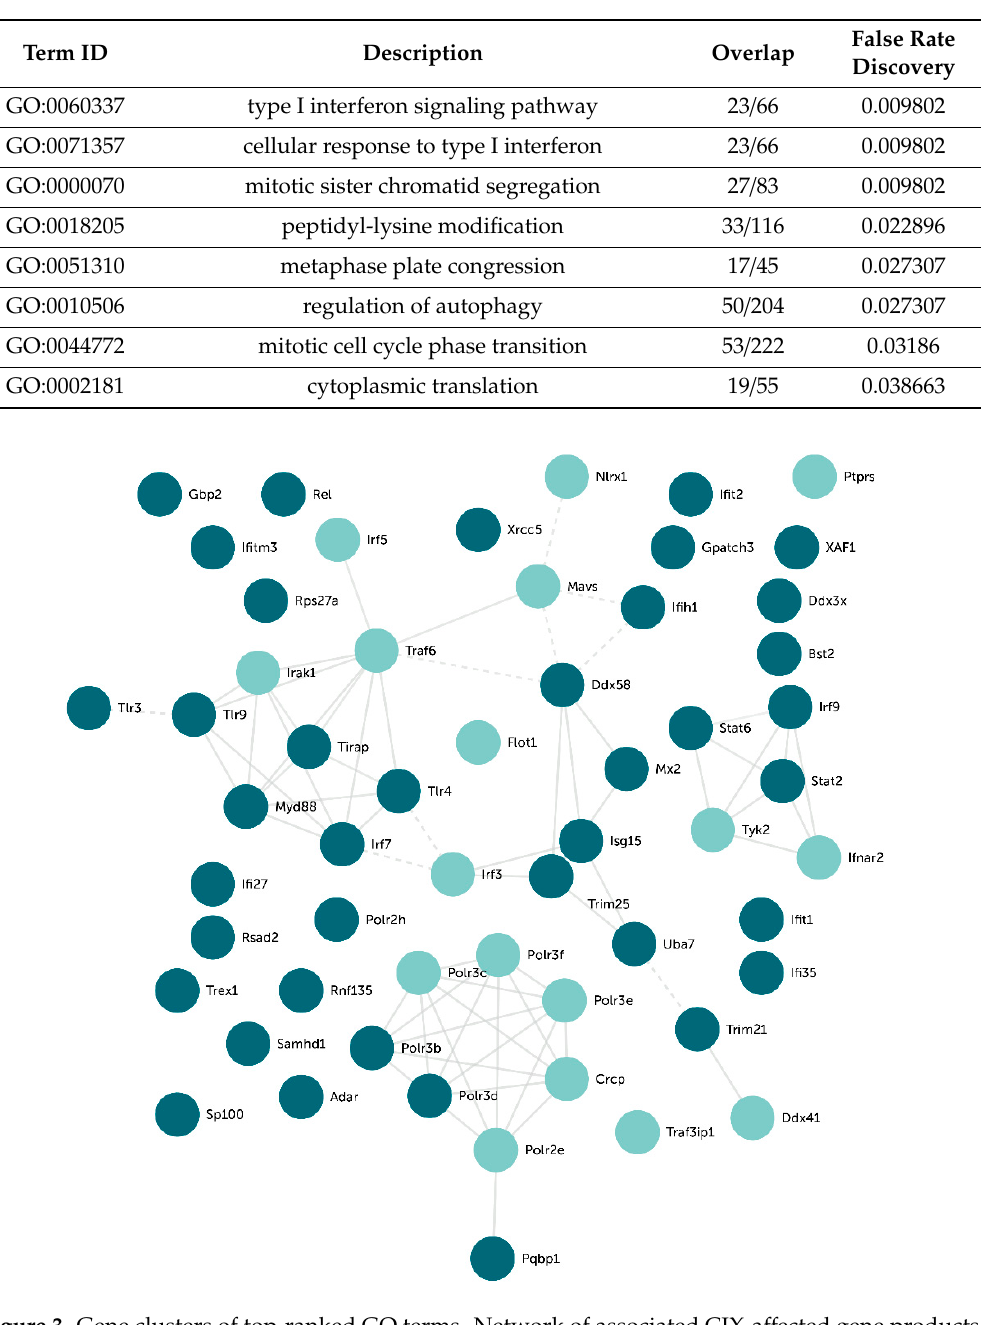
Figure 3. Gene clusters of top-ranked GO terms. Network of associated CIX-affected gene products were generated using STRING using only curated databases as active interaction sources. Light green nodes are upregulated, whereas dark green nodes are downregulated in 4T1 cells in response to CIX (15 µ M, 24 h). TLR signaling stands out as a key cluster in this network. Solid lines represent intra-cluster edges, dotted lines represent inter-cluster edges.